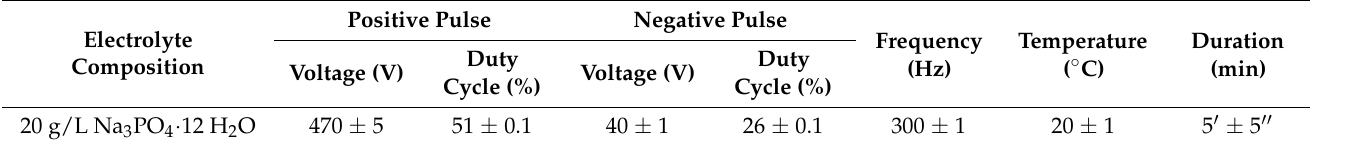
Table 1. PEO processing